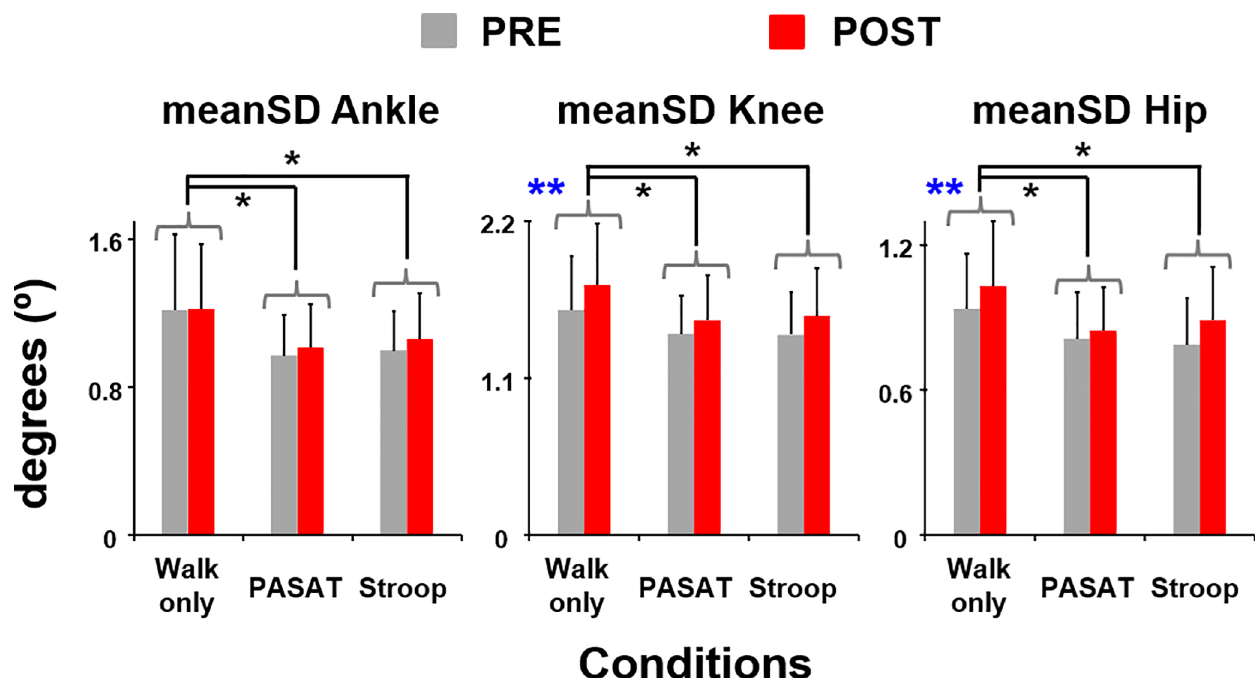
Fig 4. Mean standard deviation (meanSD) of the lower-limb joint motions. meanSD of ankle, knee, and hip joint angles before (PRE, grey bars) and after (POST, red bars) the exercise session. Error bars represent 1 STD. (cid:3)(cid:3) indicates significant difference between the PRE and POST. (cid:3) indicates significant difference from the walking only condition (THSD, p <